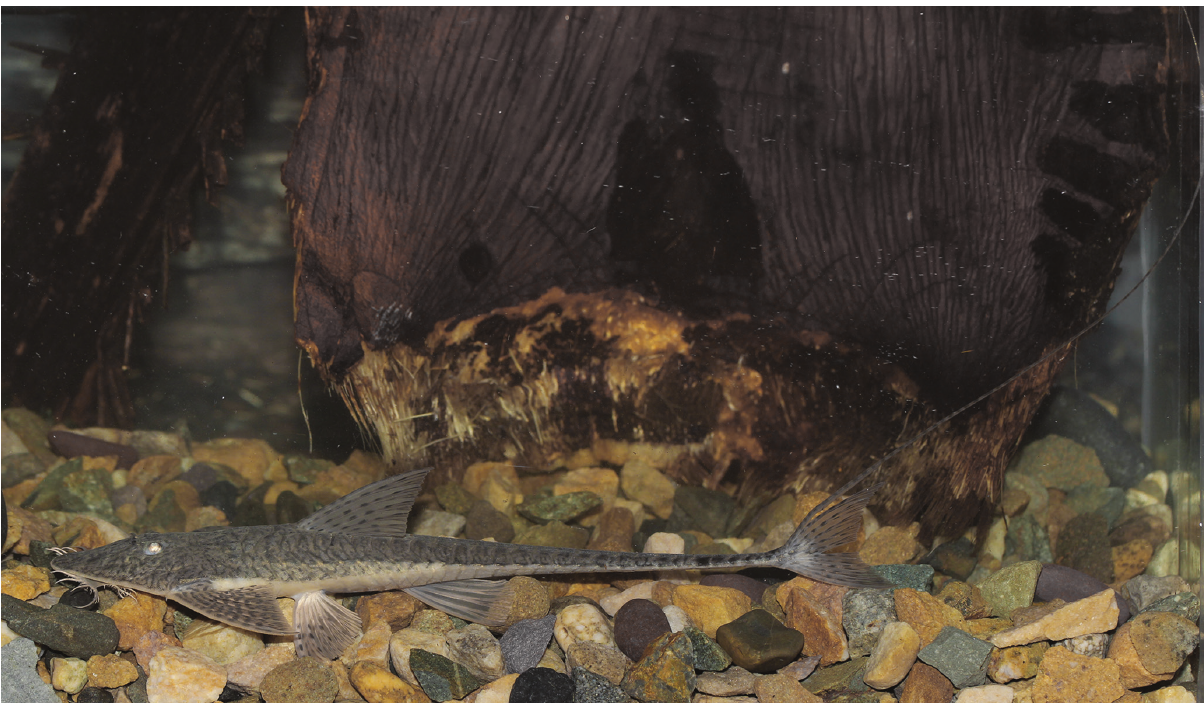
Fig. 4. Pseudohemiodon unillano , paratype , IAvH-P 19088, 183.2 mm SL. Coloration in live specimen. Photograph by A.